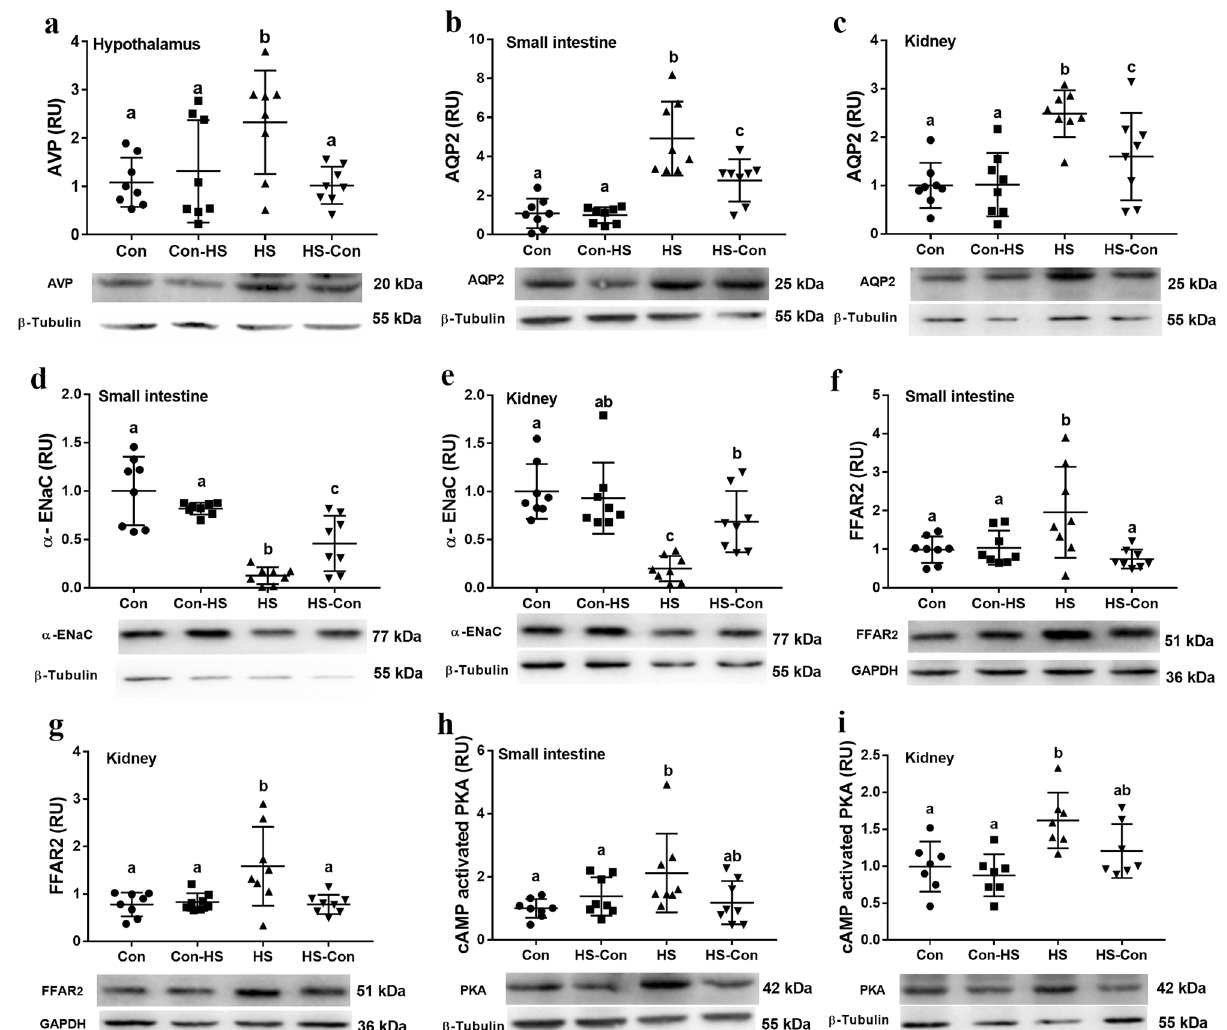
Fig. 4 Caecal microbiota transplant (CMT) affected molecular markers related to osmoregulation. Arginine vasopressin (AVP) in the hypothalamus ( P = 0.012) ( a ); aquaporin 2 (AQP2) in small intestine ( P < 0.001) ( b ) and in kidney ( P < 0.001) ( c ); epithelial sodium channel ( α - ENaC) in small intestine ( P < 0.001) ( d ) and in kidney ( P < 0.001) ( e ); free fatty acid receptor 2 (FFAR2) in small intestine ( P = 0.006) ( f ) and in kidney ( P = 0.003) ( g ); and cAMP-activated Protein Kinase (PKA) in small intestine ( P = 0.026) ( h ) and in kidney ( P < 0.001) ( i ). All blots derived from the same experiment and were processed in parallel. Data are presented as means ± standard error of the mean (s.e.m), and bars which do not share the same letter are signi fi cantly different from each other ( P < 0.05). Con, gerbils drank tap water ad libitum and received sterile saline as sham-CMT via oral gavage; Con-HS, Con gerbils received microbiota from HS gerbils via oral gavage; HS, gerbils drank water with 8% NaCl ad libitum and received sterile saline as sham-CMT via oral gavage; HS-Con, gerbils drank HS water ad libitum and received